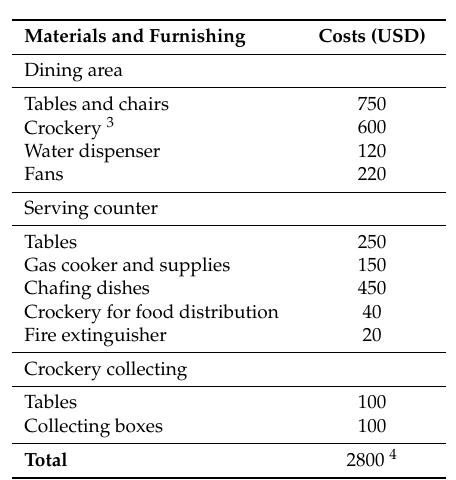
Table 1. Costs for the setup of the canteen (circa 100 seats capacity) 1,2 .